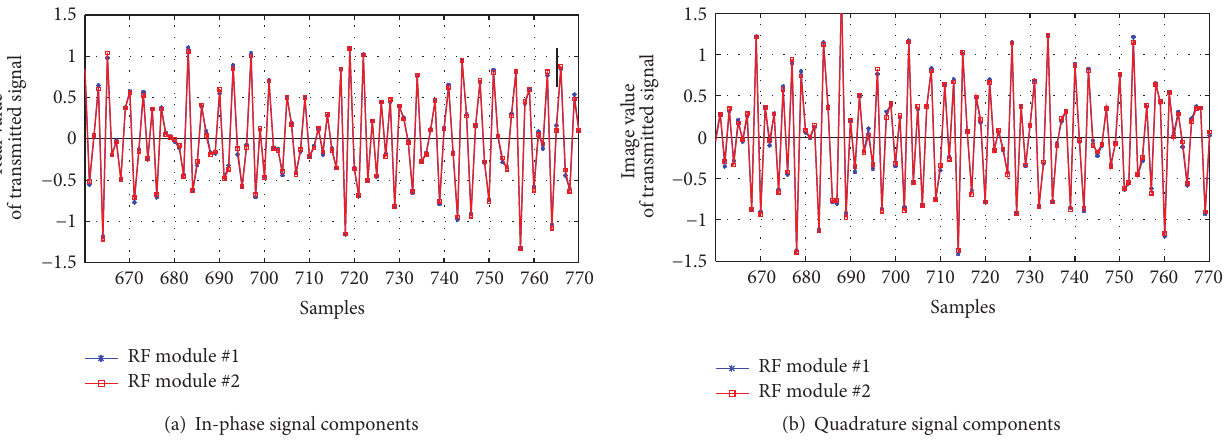
Figure 12: In-phase and quadrature signal components captured after calibration during downlink. Table 2: Phase error according to